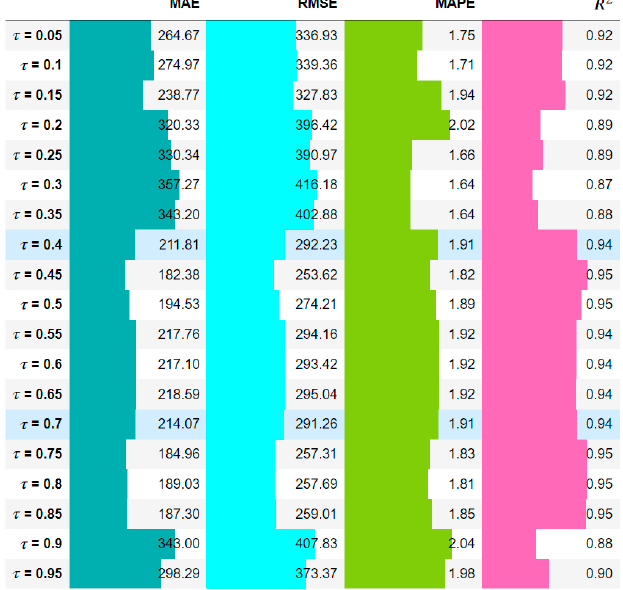
Figure 8. Prediction metrics for different levels of 𝜏 .